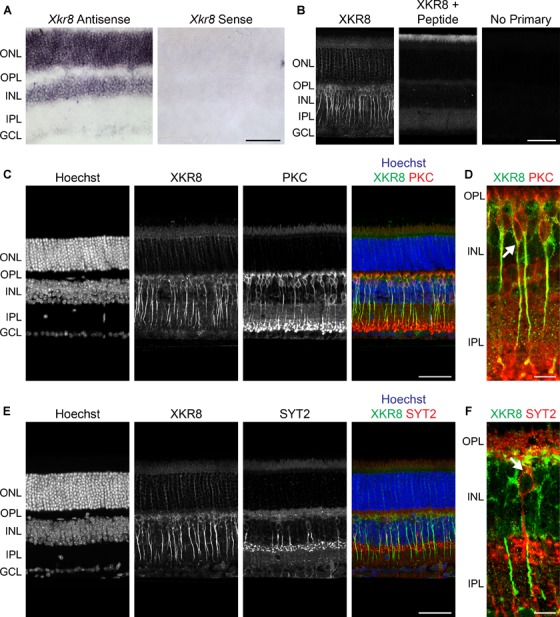
(A)
Xkr8 mRNA was localized in the mature B6/J mouse retina using in situ hybridization, evincing conspicuous expression in the ONL and INL, and weaker expression in the GCL (left). No signal was detected using the control (sense) riboprobe (right). (B) XKR8 immunofluorescence in the mature B6/J retina, showing prominent labeling of bipolar cell somata and axons, as well as lighter labeling of cells in the ONL and GCL (left). Positive control sections, in which the primary antibody was pre-absorbed with XKR8 peptide sequence (middle), and negative control sections, in which the primary antibody was omitted (right), showed abolition of labeling. (C) XKR8 labeling of bipolar cells includes the population of RBCs, though excluding their terminals in the IPL. (D) Higher magnification image showing XKR8 localized to RBC somata (e.g., arrow) and axons. Note as well-occasional XKR8-positive bipolar cells that are not RBCs (i.e., are PKC-negative). (E) XKR8 labeling is notably lighter in the membrane of CBC2 cells. (F) Higher magnification image showing XKR8 labeling in SYT2+ soma (arrow). Scale bar = 50 μm for (A–E); = 10 μm for (D,F).